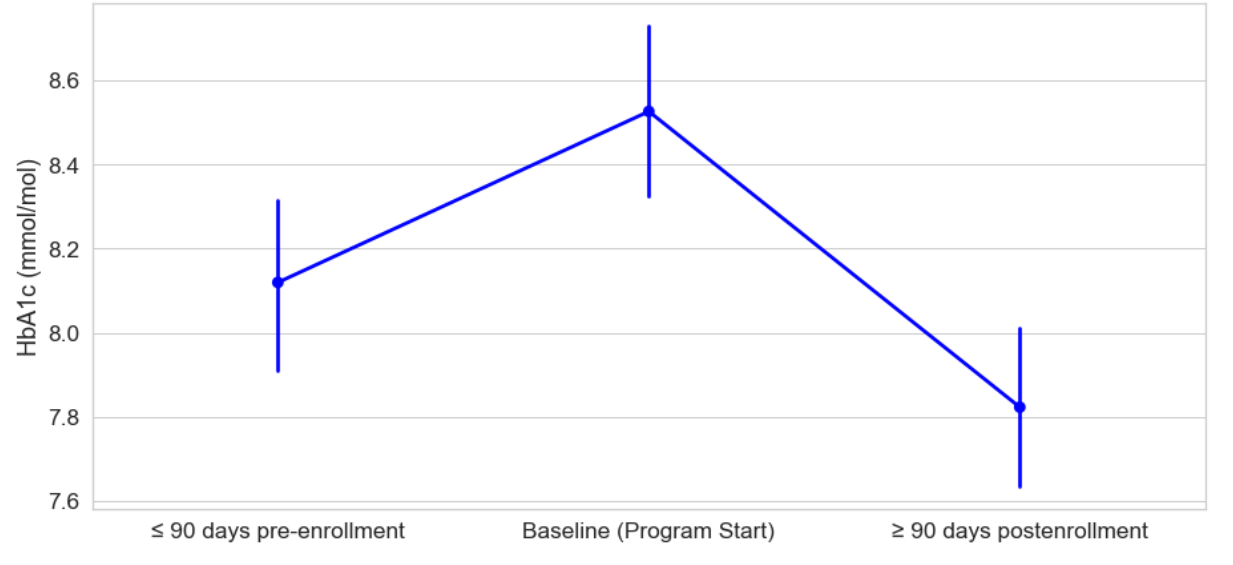
Figure 5. Estimated marginal means of HbA 1c as a function of measurement period (N=211). HbA 1c : hemoglobin A 1c